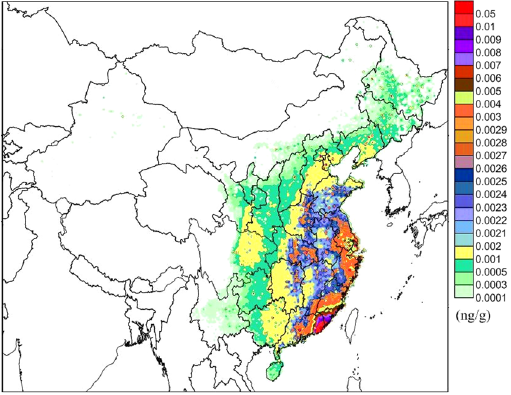
Figure 4. The concentration in the second soil layer in 2005. The map was drawn by the software of Surfer 9.0, http://www.goldensoftware.com/.